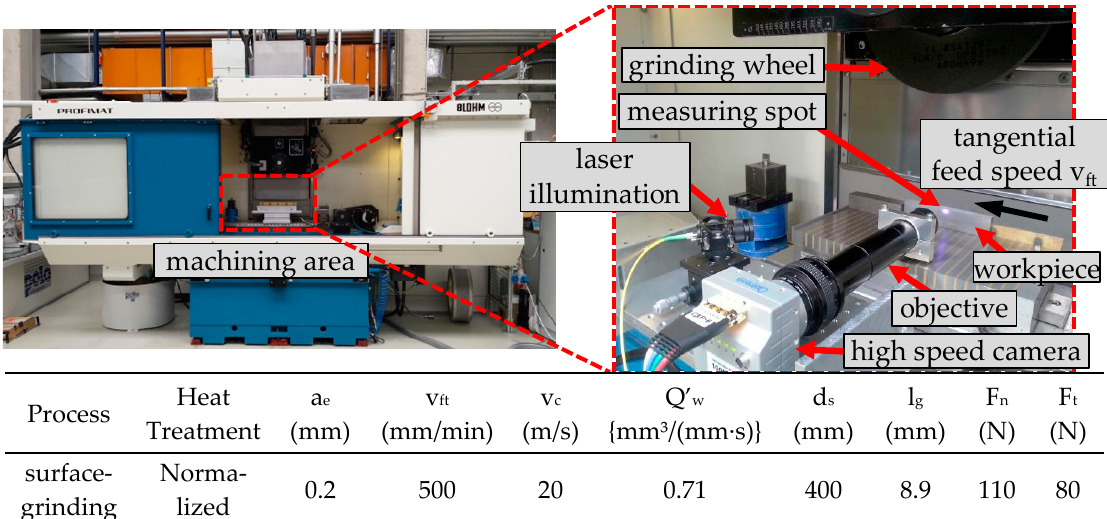
Figure 3. Blohm Profimat 412 HSG grinding machine and integrated measuring setup with process parameters.